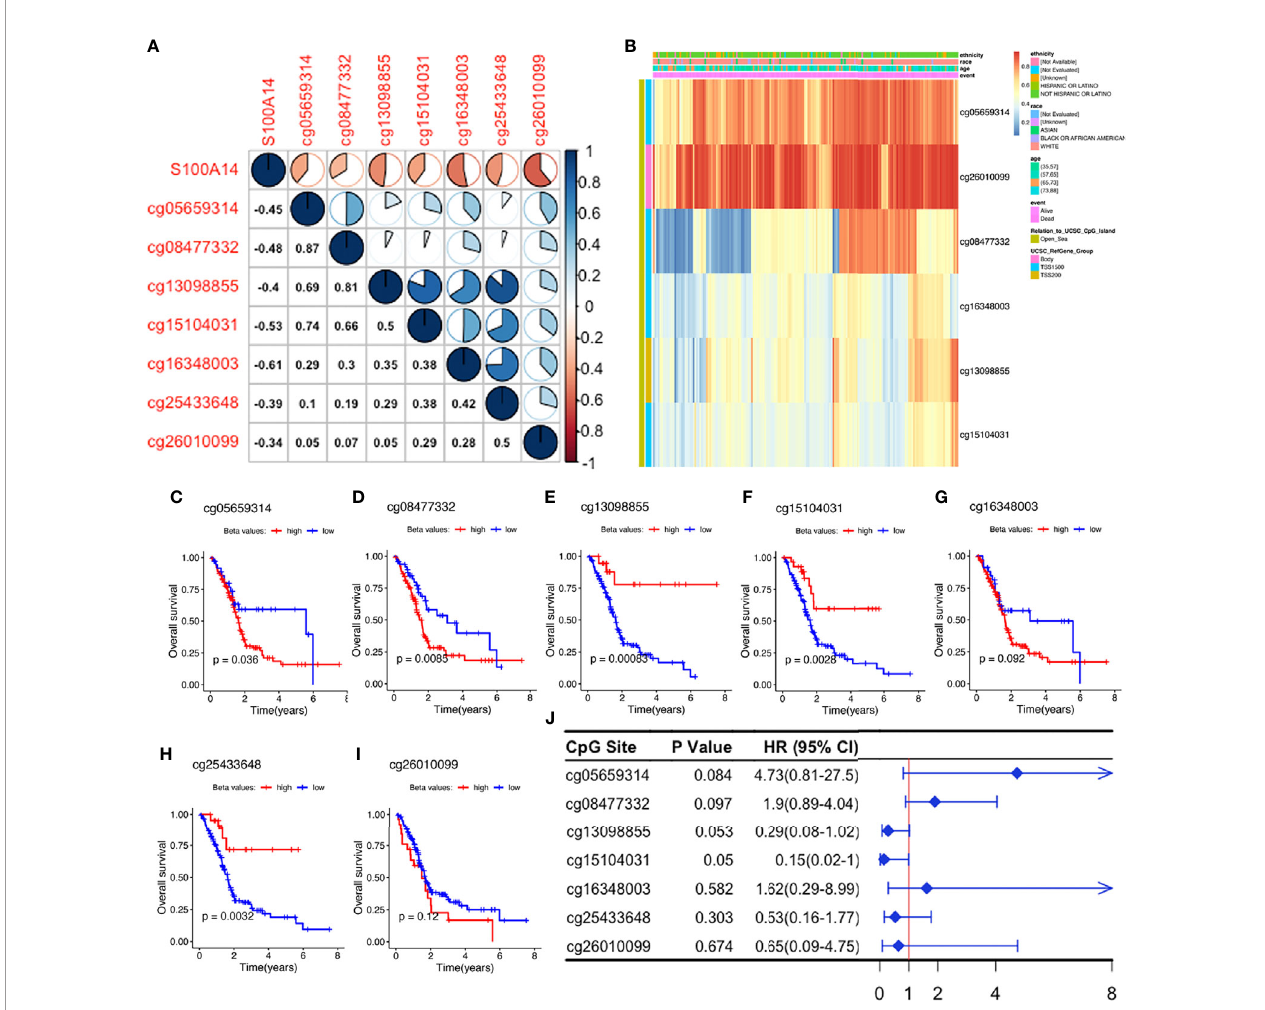
FIGURE 4 | Exploration of S100A14 cg sites. (A) Pearson ’ s correlation between DNAm levels of the cg sites and S100A14 mRNA expression levels. (B) DNAm beta value heatmaps of S100A14. (C – I) K-M survival curves showing OS of patients with high and low beta values at each cg site in the TCGA-PAAD dataset. (J) Univariate Cox regression analysis for OS of S100A14 cg sites in the TCGA